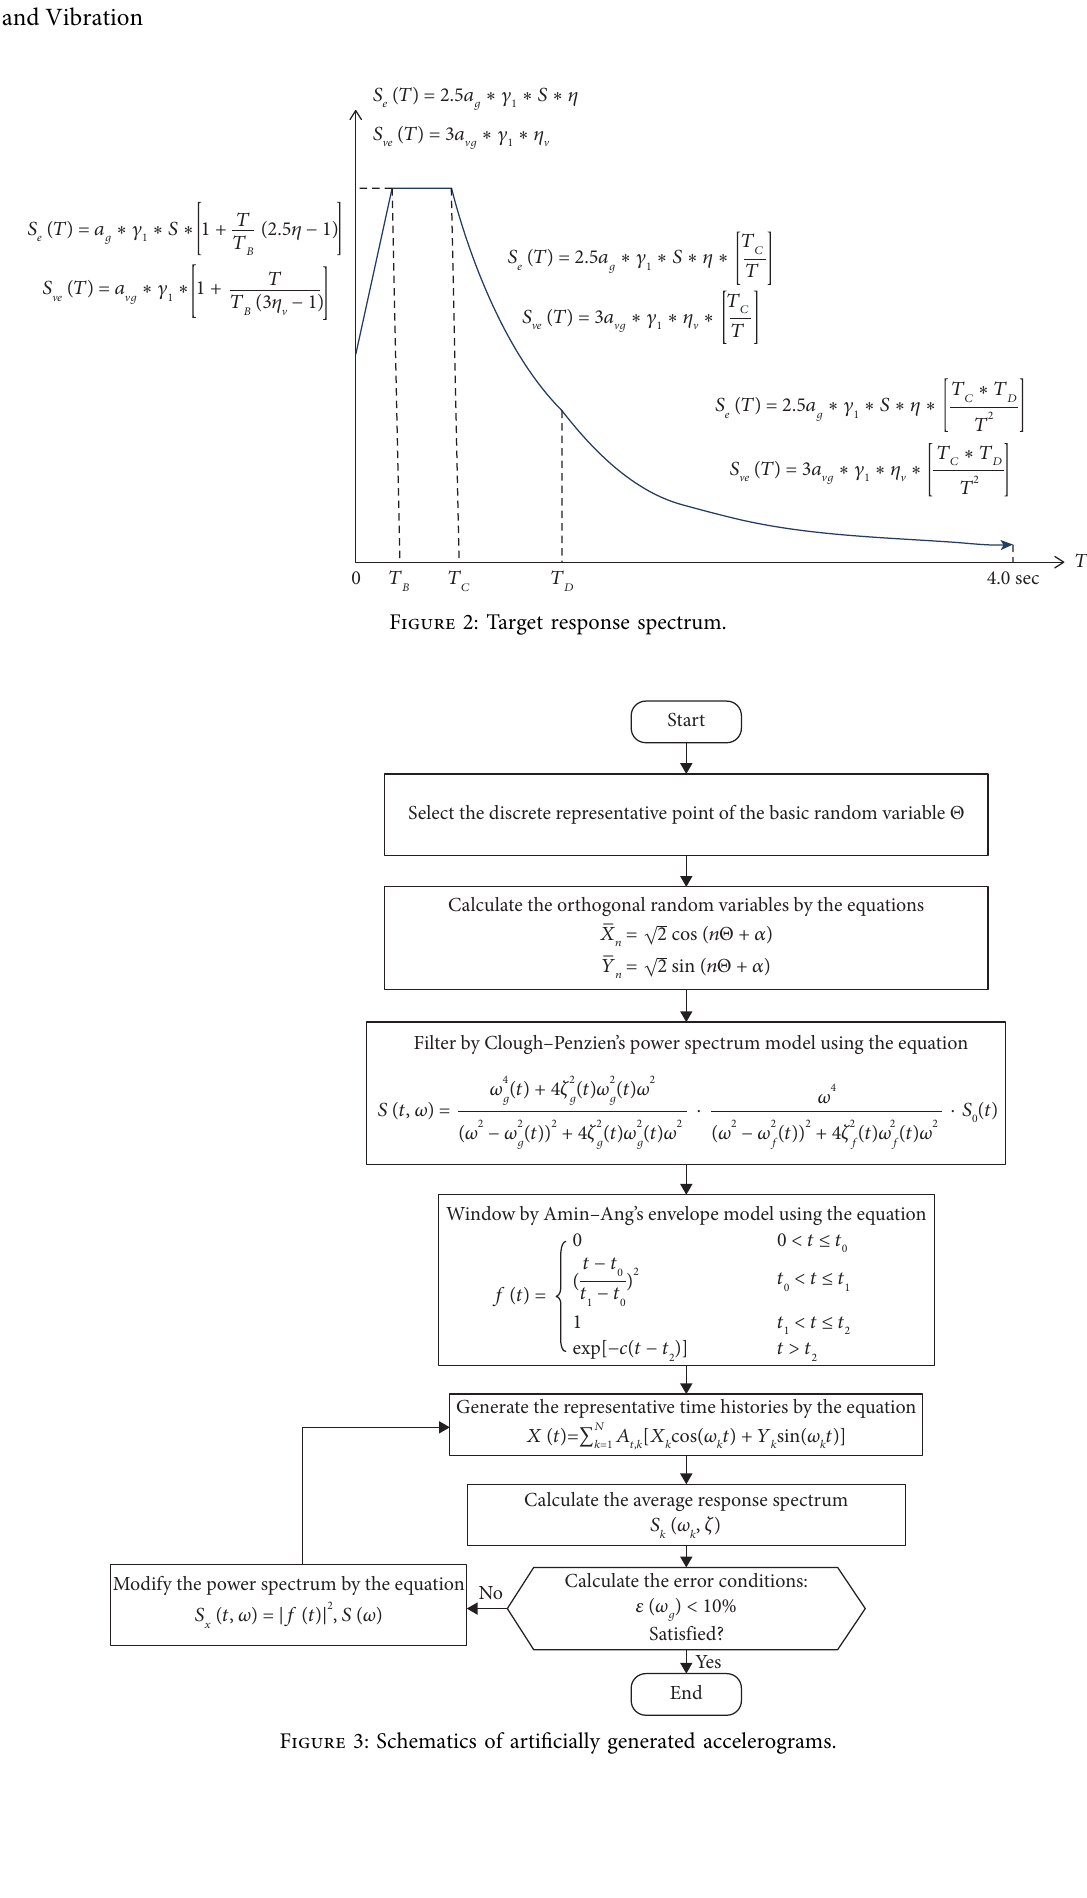
Figure 3: Schematics of artificially generated accelerograms.